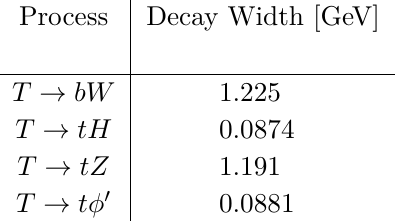
Table 1. T decay width for a benchmark scenario with m ( T ) = 2 TeV. We assume that the b -quark has no mixing with new heavy fermions. This scenario is discussed in more detail in the